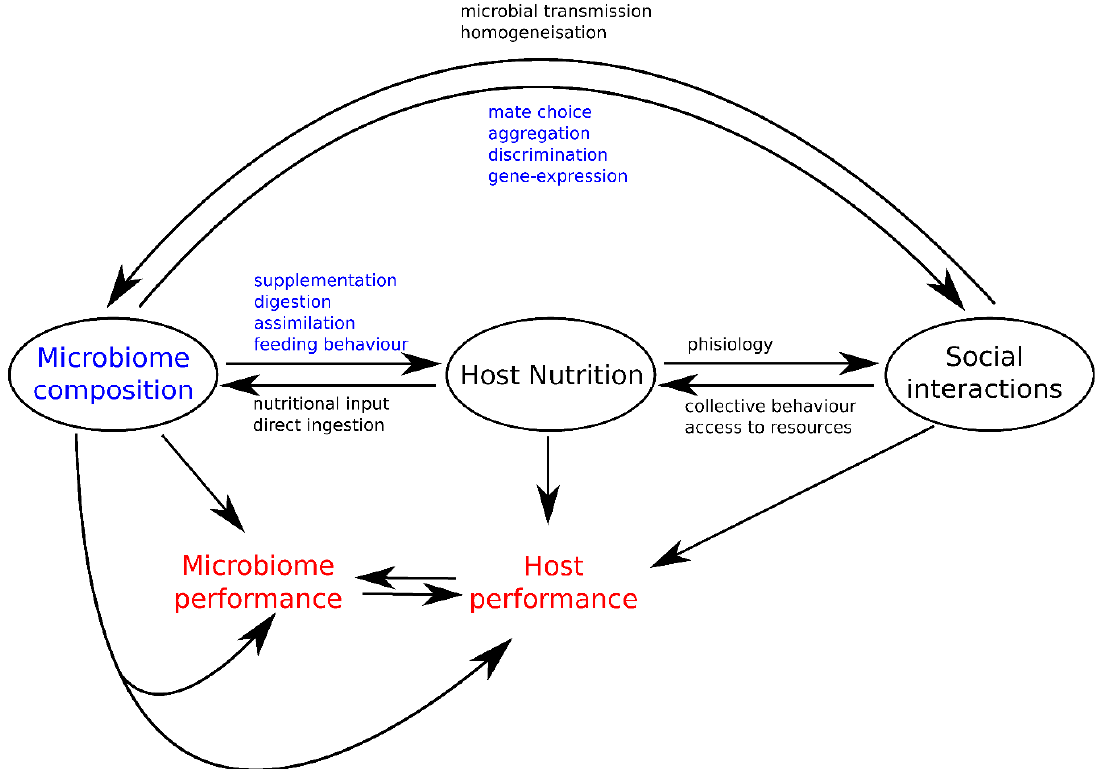
Figure 4. Nutritional interactions between the gut microbiota, host feeding strategies and host social interactions .